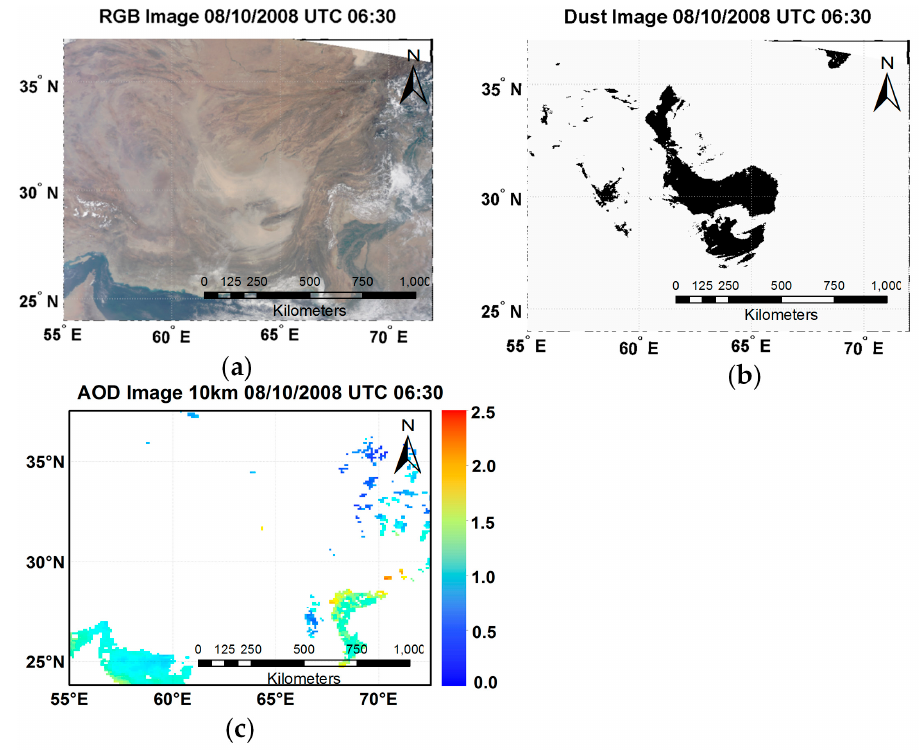
Figure 8. Dust storm cross Pakistan and Afghanistan on 10 August 2008. ( a ) MODIS true color image; ( b ) dust image; and ( c ) Aerosol Optical Depth (AOD) image.